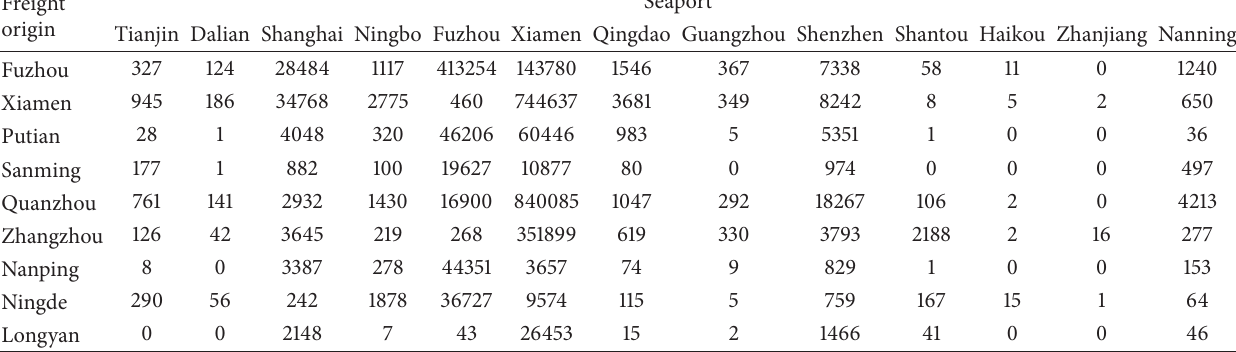
Table 4: Export volume (in tons/year) between cities in Fujian province and various seaports.